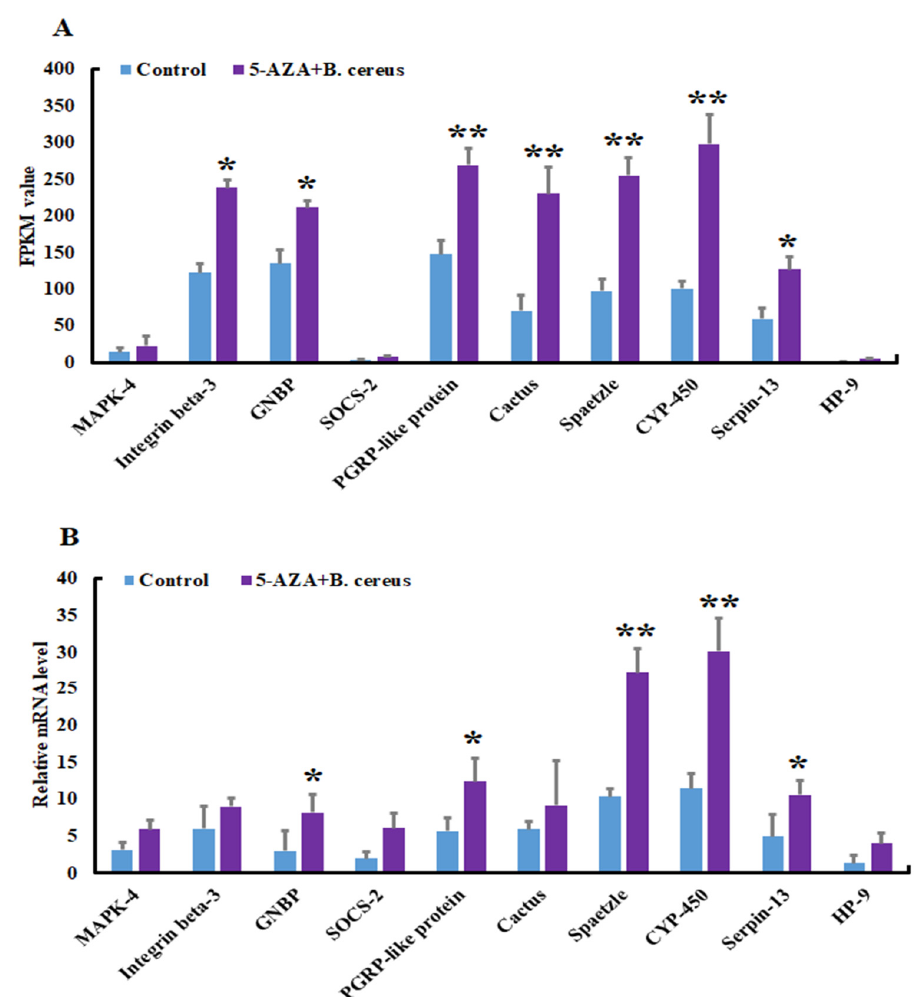
Figure 5. The expression of selected differentially expressed genes for the validation of data. ( A ): Expression of 10 selected unigenes expression (FPKM value) in the experimental and control group. ( B ): Quantitative RT-PCR verification of RNA sequence data. X-axis and Y-axis show the 10 selected differentially expressed genes and the relative expression ( B. cereus -injected vs. 5-AZA+ B. cereus - injected), respectively. The sequences include c89459.graph_c0, c92066.graph_c0, c90624.graph_c0, c91406.graph_c2, c93759.graph_c1, c93774.graph_c0, c77163.graph_c1, c85165.graph_c0, c89772.graph_c1, c85340.graph_c0 encoding mitogen-activated protein kinase kinase 4, integrin beta pat-3-like, GNBP, suppressor of cytokine signaling 2-like isoform X2, peptidoglycan recognition protein-like protein, cactus, spaetzle, cytochrome P450, serine protease inhibitor 13 precursor, and hemolymph proteinase 9. (* p < 0.05, ** p <